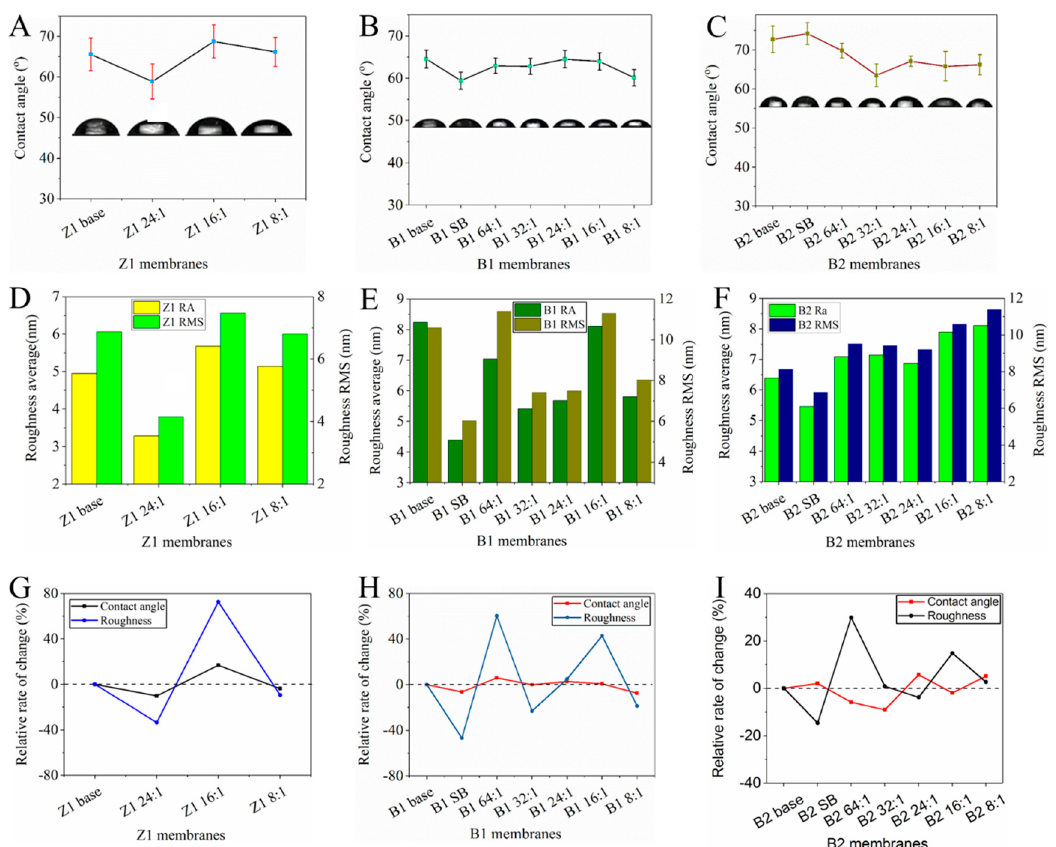
Figure 8. Contact angels of ( A ) Z1, ( B ) B1, and ( C ) B2 membranes, and the surface roughness and root mean square of ( D ) Z1, ( E ) B1, and ( F ) B2 membranes, and relative change rate of contact angle and roughness of ( G ) Z1, ( H ) B1, and ( I ) B2 membranes.